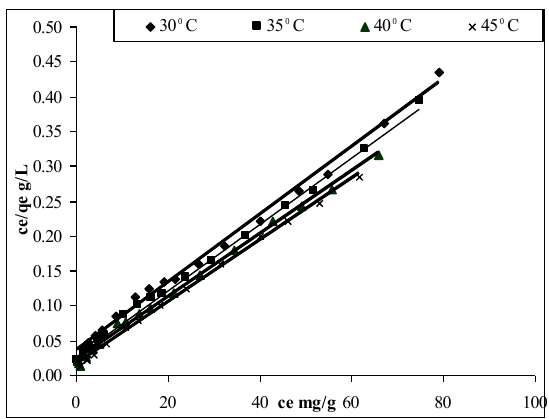
Figure 6 . Langmuir Isotherm for Adsorption of RR onto PPC.